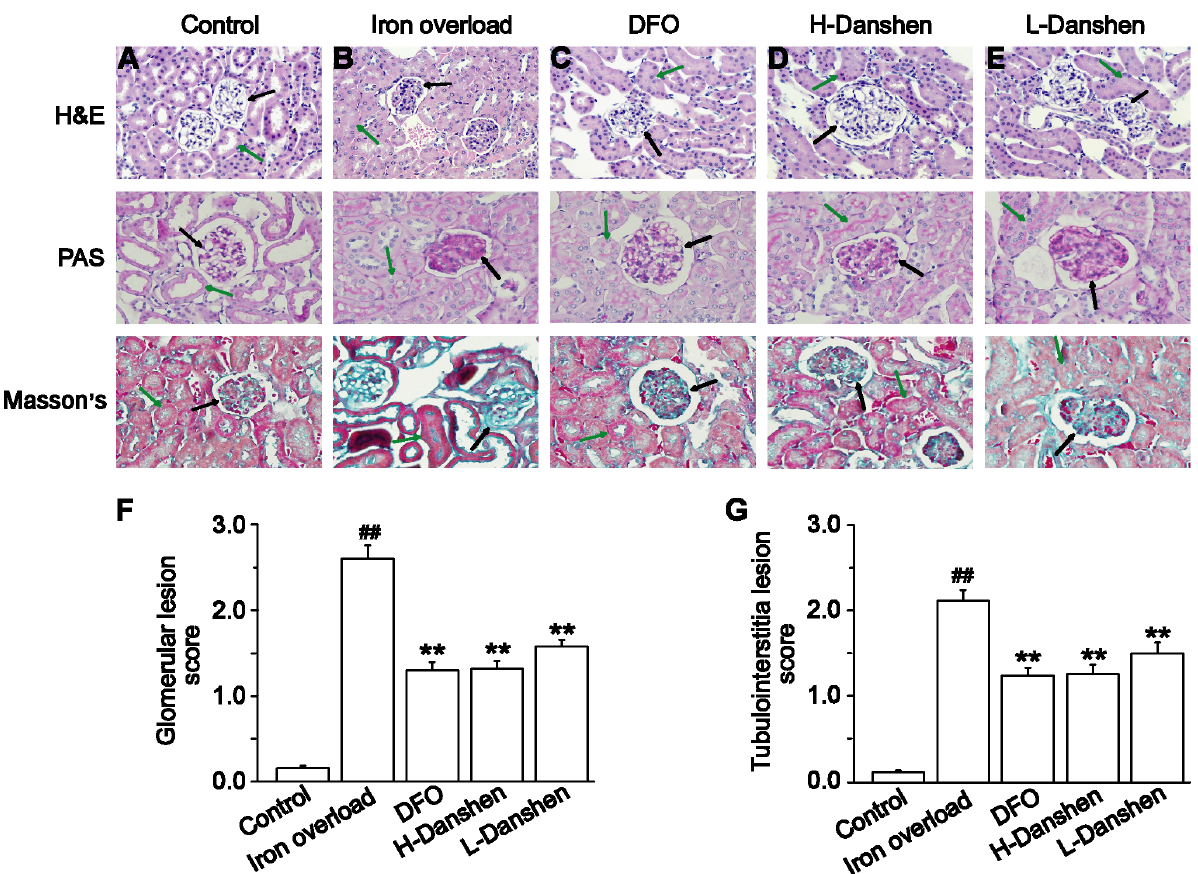
Figure 4. Effects of Danshen injection on morphological changes in kidneys. Representative microscopic photographs of H&E, PAS and Masson’s trichrome stained kidney tissue sections (magnification 400 6 ). Kidneys were obtained from the control (A), iron overload (B), DFO (C), H- Danshen (D) and L-Danshen (E) groups. Scores for glomerular lesions (F) and tubulointerstitial lesions (G) are shown. Black arrows indicate histological changes of glomerular cells, and the green arrows indicate histological changes of tubulointerstitial cells. Data are presented as means 6 S.E.M of 15 animals per group. **P , 0.01, compared with iron overload group; ## P , 0.01, compared with control group. doi:10.1371/journal.pone.0074318.g004 histological changes, and the scores for glomerular and tubuloin- terstitial lesions revealed an approximate 21-fold increase of the lesion area compared with that in the control group ( P , 0.01)